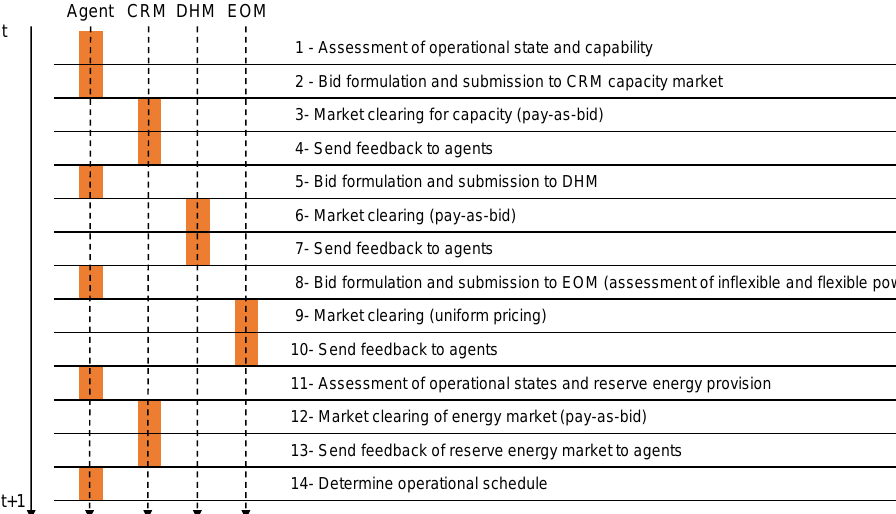
Figure 2. Sequence diagram representing each simulation step in flexABLE